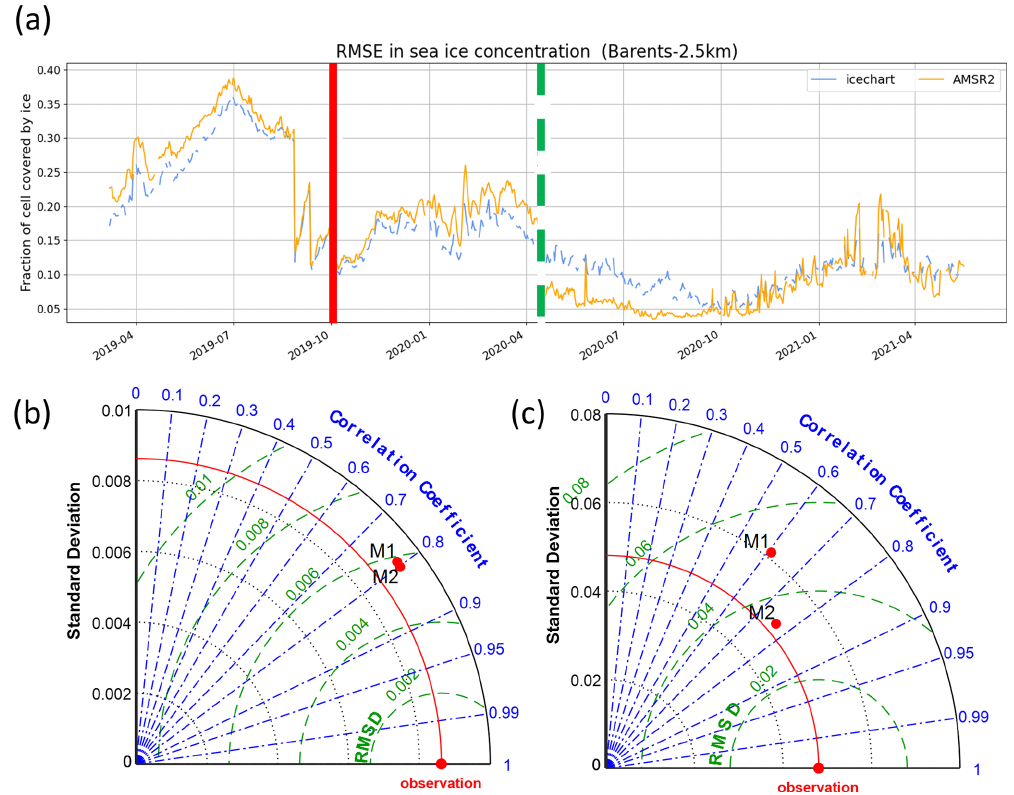
Figure 4. (a) Root mean square error (RMSE) of the Barents-2.5km model for sea ice concentration, before and after using time-varying boundaries (vertical red line) and before and after data assimilation began (dashed vertical green line), calculated against AMRS2 and Sval- bard ice chart observations (see Sect. 2.3.1). (b, c) Taylor diagrams for the operational Barents-2.5km simulations and AMRS2 observations, without (M1) and with (M2) the time-varying boundaries; (b) daily results averaged over the whole model domain; (c) spatially resolved daily results. The red line in the Taylor charts depicts the standard deviation of the observations. The green curved isolines show the RMSE, and the correlation coefficient is shown in